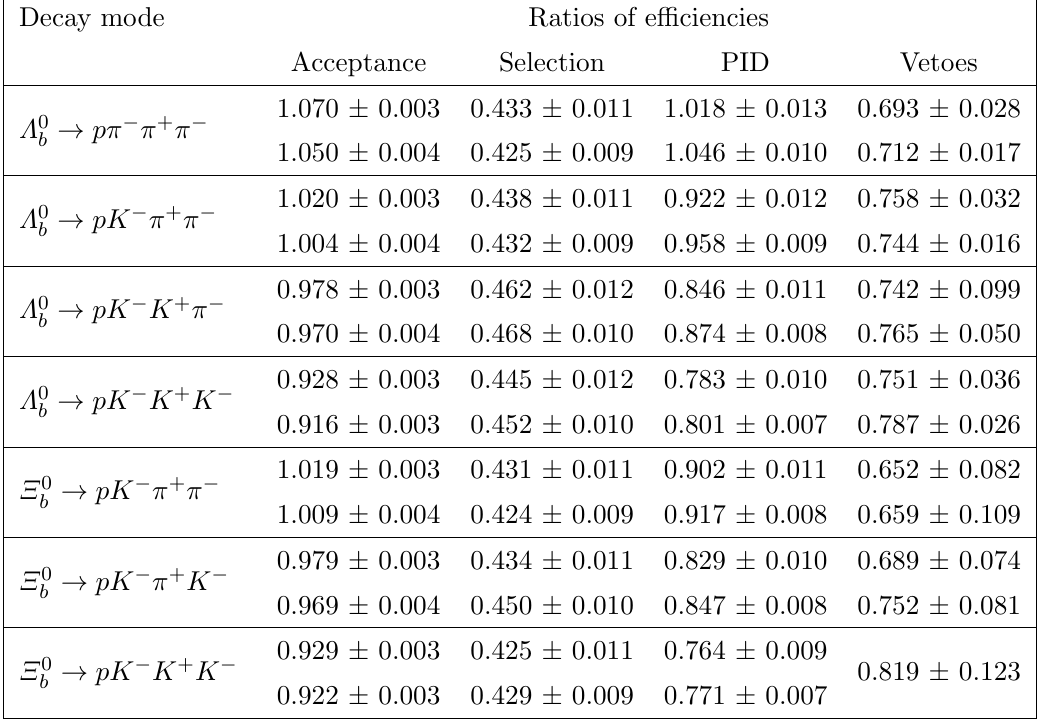
Table 2 . Ratios of the normalisation decay mode e(cid:14)ciencies, relative to the signal decay mode as used in eq. (5.1), for ((cid:12)rst row) 2011 and (second row) 2012. The last column shows the e(cid:14)ciency